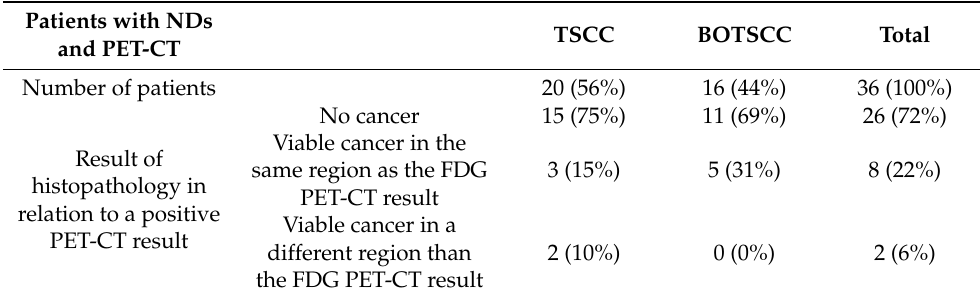
Table 3. Patients with data on NDs performed after a positive FDG PET-CT